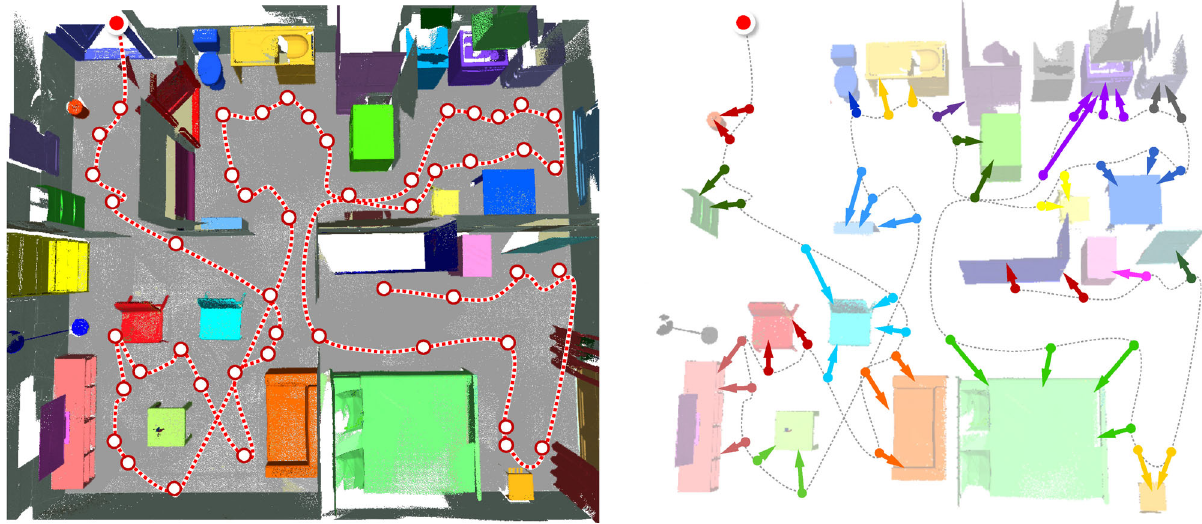
Fig. 11 Global and local view planning results. Reproduced with permission from Ref. [19], c (cid:2) ACM